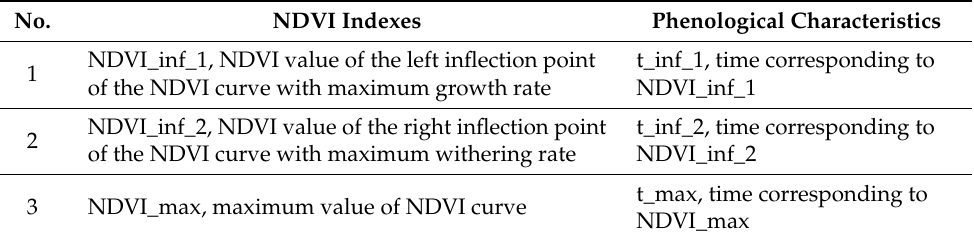
Figure 2. Sketch of asymmetric logistic curve to fit the NDVI series and characteristic points. Table 2. Selected phenological characteristics and corresponding NDVI indexes.